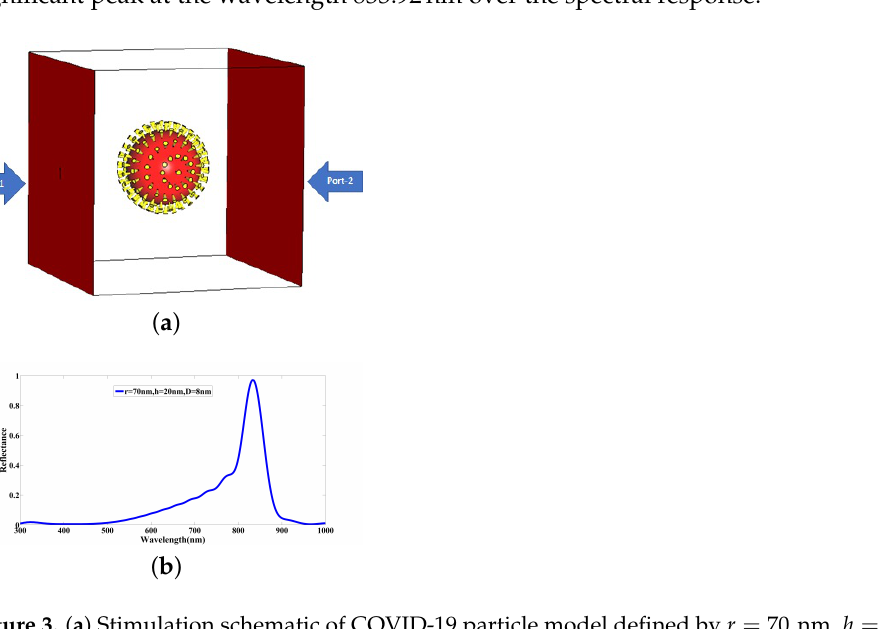
Figure 3. ( a ) Stimulation schematic of COVID-19 particle model defined by r = 70 nm, h = 20 nm, D = 8 nm, N = 147, and implemented in CST with input and output ports. ( b ) The simulated reflectance spectrum of the COVID-19 particle model under the light